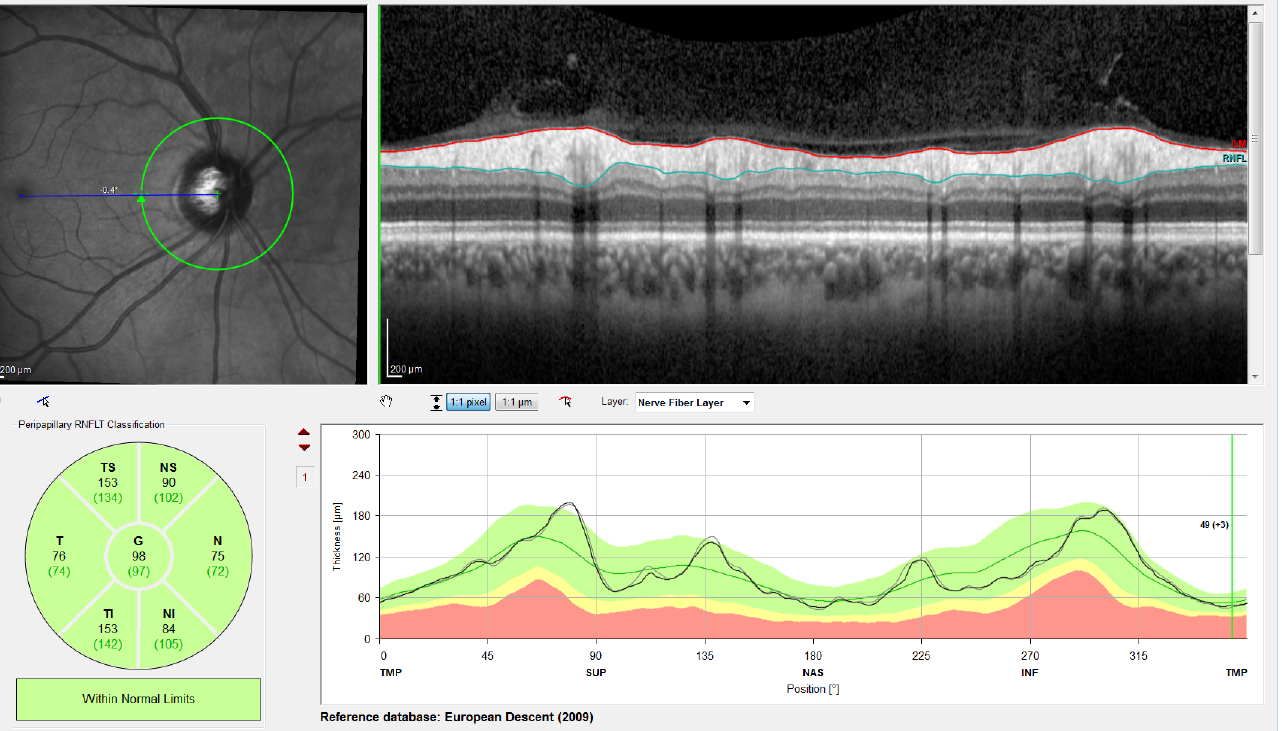
Figure 3. Screenshot of Spectralis. From left to right and top to bottom: Retinal fundus image centered on the optic disc (the green circle indicates the location of the peripapillary B-scan, which is shown on the right with the segmentation of the RNFL); 2D peripapillary B-scan OCT with Cartesian coordinates; estimated mean values for RNFL layer thickness for each sector and the overall mean; rectified outline of the RNFL with estimated thickness and reference values according to the database European Descent